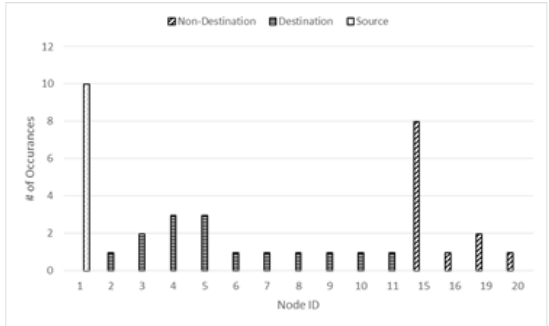
Fig. 15. Number of Paths Each Node Participates in for a Multicast Tree with 20 Nodes and 10 Destinations